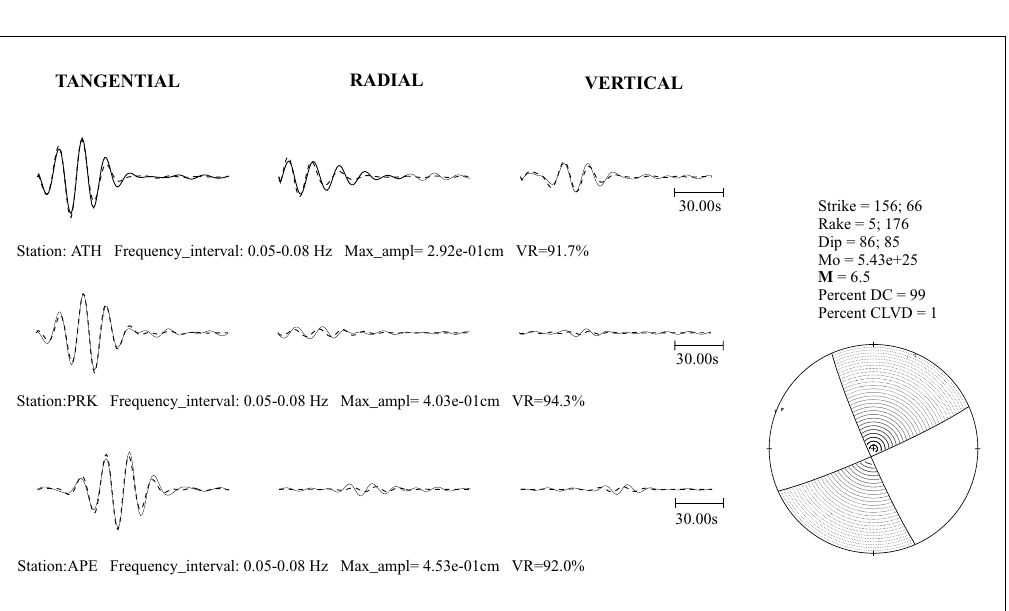
Fig. 5. Results of the time domain moment tensor inversion. In the left part the comparison between observed (solid line) and synthetic (dashed line) regional broadband waveforms is shown. In the right part the beach-ball, of strike, dip and rake for the two nodal planes, the scalar seismic moment, M M are also given. The time scale is shown below the vertical component, while information on the station name, examined frequency range, maximum observed amplitude (in cm) and variance reduction is shown below wave-